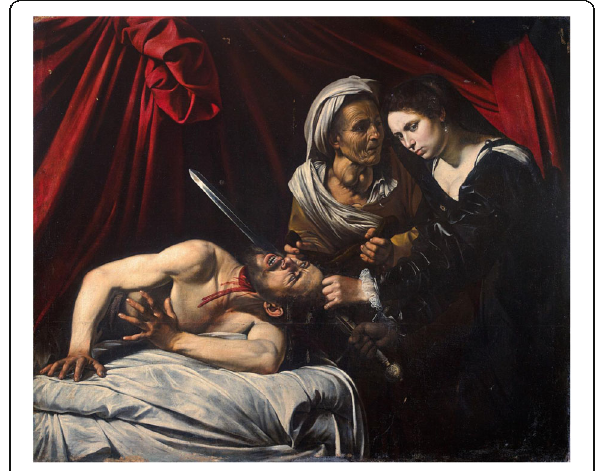
Fig. 2 The painting found in Toulouse. (Available from